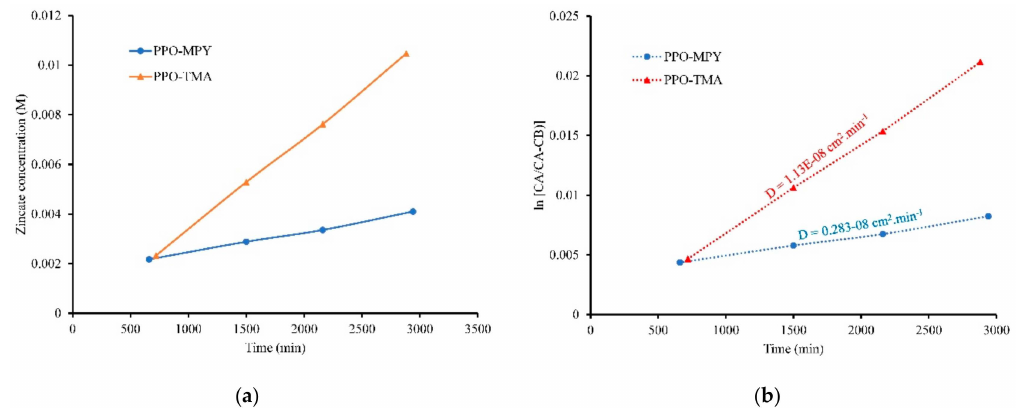
Figure 6. Variation of the zincate concentration in the right chamber vs. time ( a ) and zincate di ff usion calculation curves ( b ) for PPO–TMA and PPO–MPY